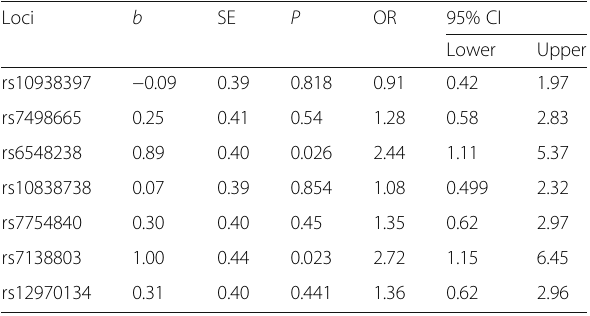
Table 6 Univariant logistic analysis of the association of seven loci with type 2 diabetes Loci